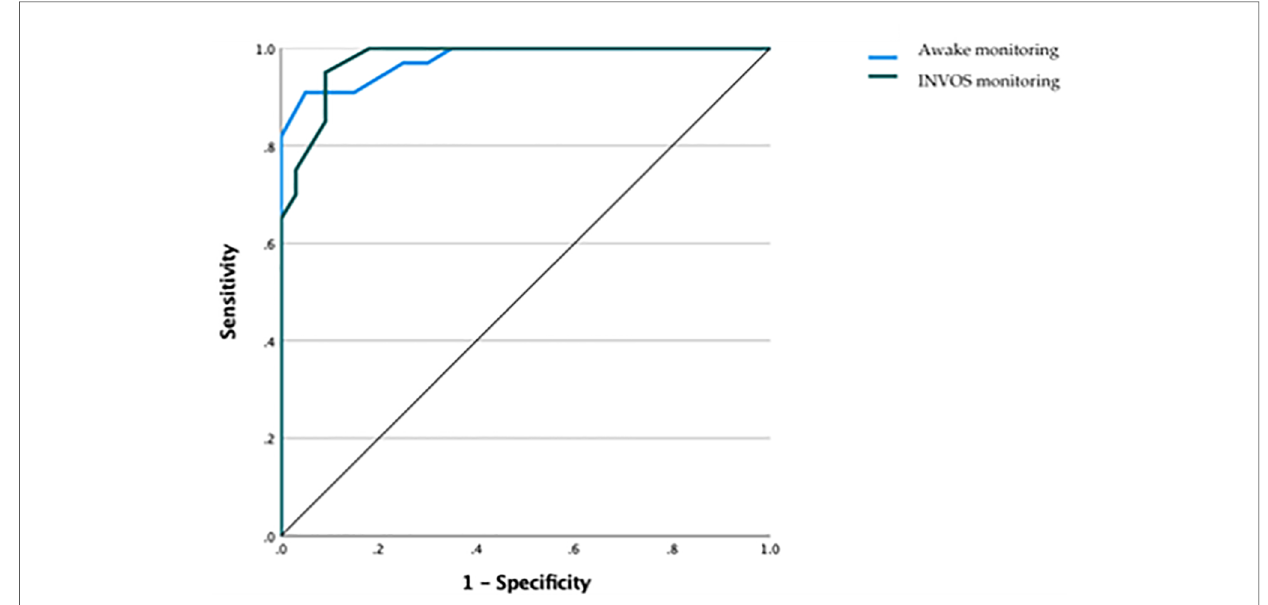
FIGURE 1 Receiver operating characteristic (ROC) curve highlighting how cerebral oximetry was able to predict ischemic events with a sensitivity of almost 98%